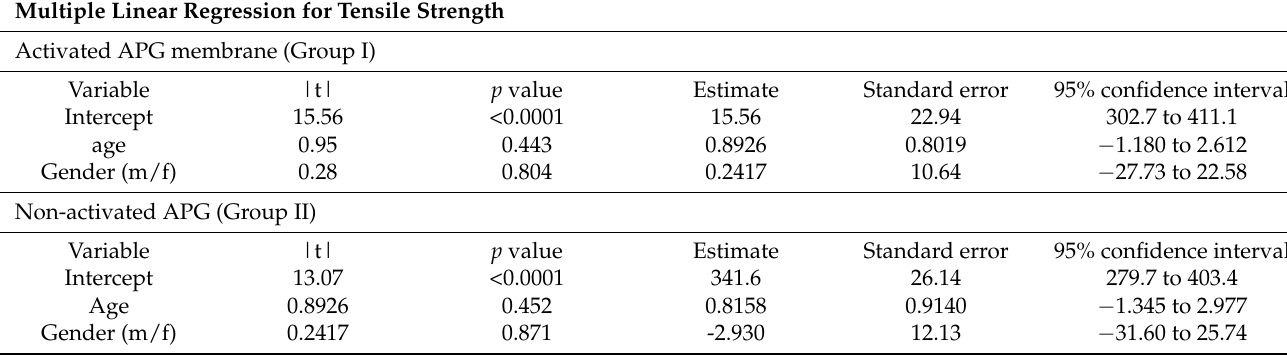
Table 2. Multiple linear regression analysis for tensile